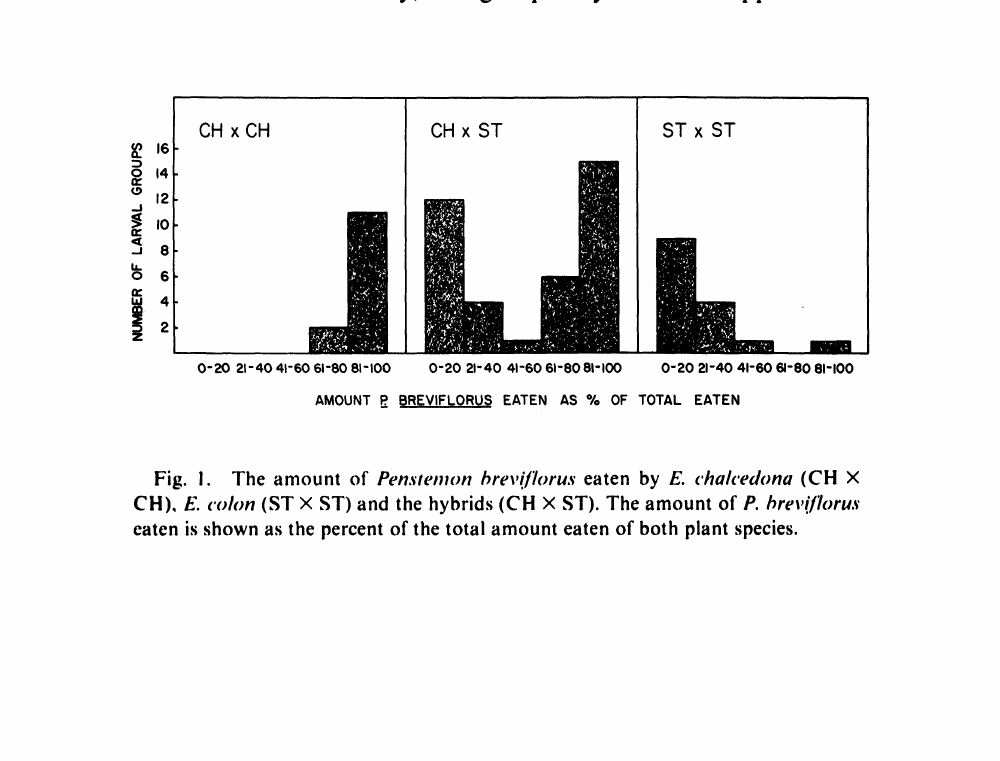
Fig. I. The amount of Penstemon hrev(/lorus eaten by E. chalcedona (CH x CH). E. co]ort (ST X ST) and the hybrids (CH x ST). The amount of P. hrev(/lorus eaten is shown as the percent of the total amount eaten of both plant